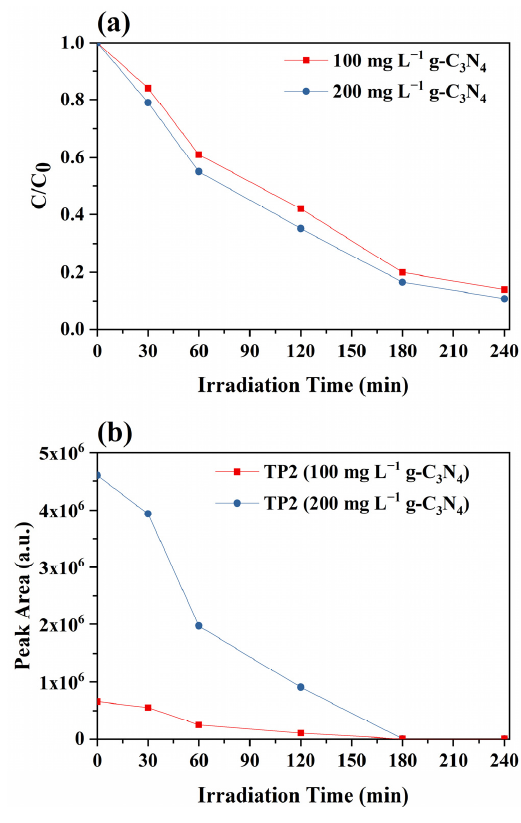
Figure 4. ( a ) Photocatalytic removal kinetics of MTZ (C 0 = 10 µ g L − 1 ) with g-C 3 N 4 (100 & 200 mg L − 1 ) under pilot scale conditions and ( b ) evolutionary profiles of the identified TP2 per photocatalyst